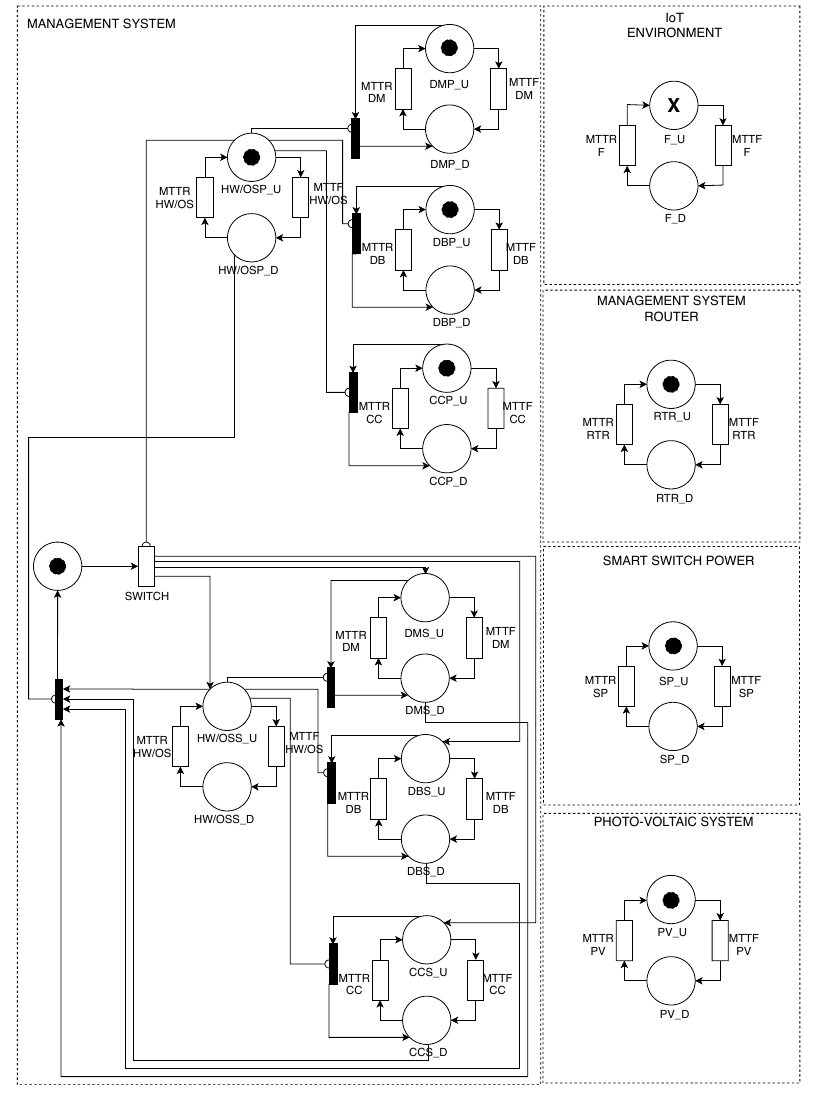
Figure 8. Stochastic Petri Net (SPN) to entire system with local